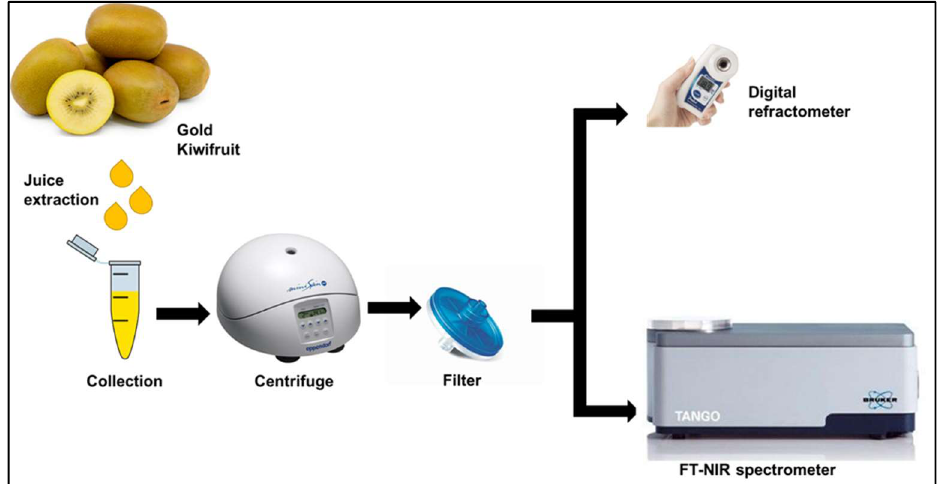
Figure 1. Experimental procedure for kiwifruit soluble solids content (SSC) measurement.